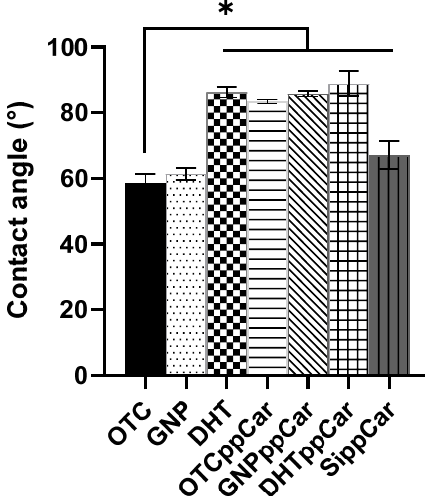
Figure 5. Water contact angle of OTC-I scaffolds before and after crosslinking and ppCar. A silicon wafer (SippCar) was used as the plasma polymerisation deposition control, which showed that carvone plasma polymerisation does not lead to a material being hydrophobic. * p ≤ 0.05 indicates significant differences in the fabricated materials.